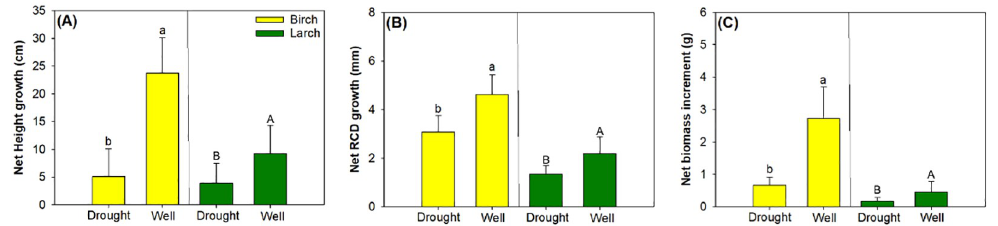
Fig 2. Net growth in height (A), root-collar diameter (RCD) (B), and biomass (C) in birch ( Betula Platyphylla ) and larch ( Larix olgensis ) seedlings subjected to drought vs well-watered conditions. Bars indicate standard deviations. Different letters indicate significant difference of raw transformed data (see S1 Table) according to Duncan test at 0.05 level. Lower case letters stand for differences for birch seedlings and capital letters for larch seedlings.